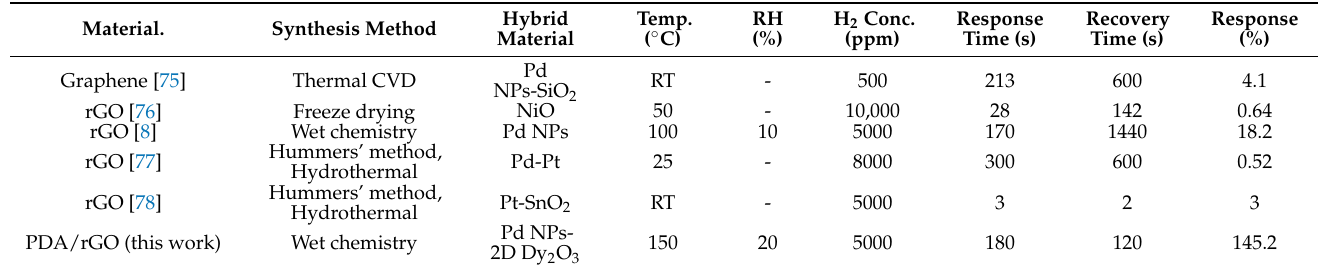
Table 4. H 2 sensing properties of different graphene-based materials functionalised by noble metals and/or metal